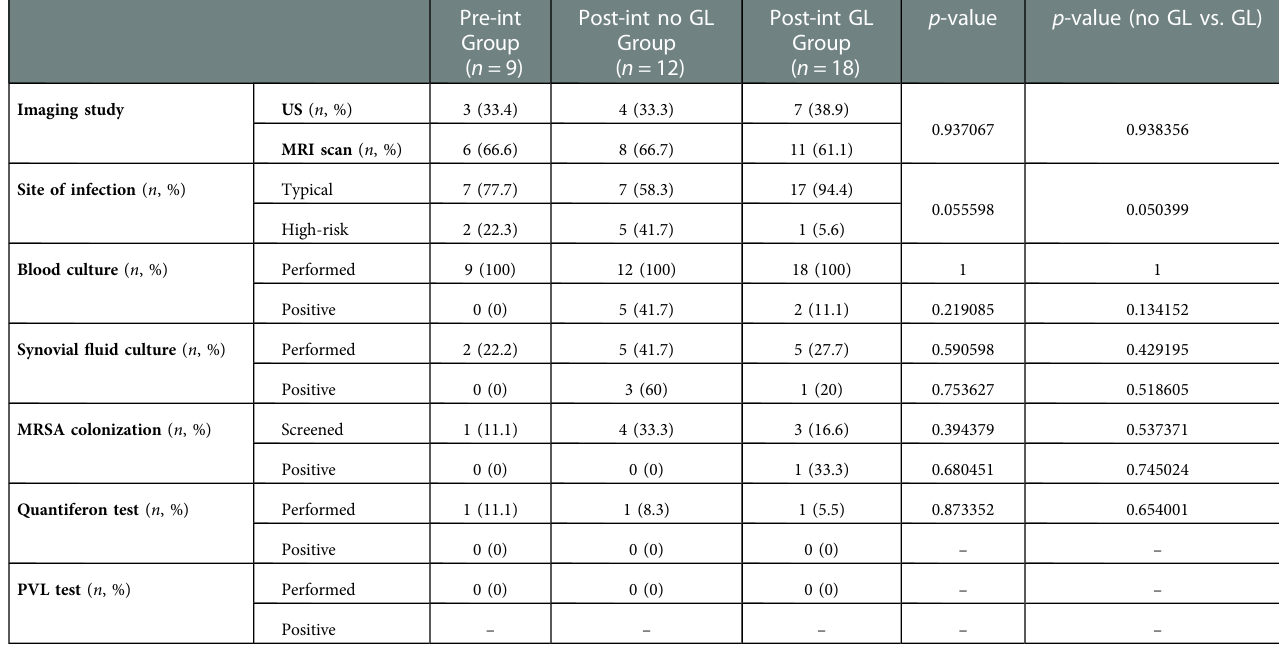
TABLE 6 Diagnostic tests - SA.